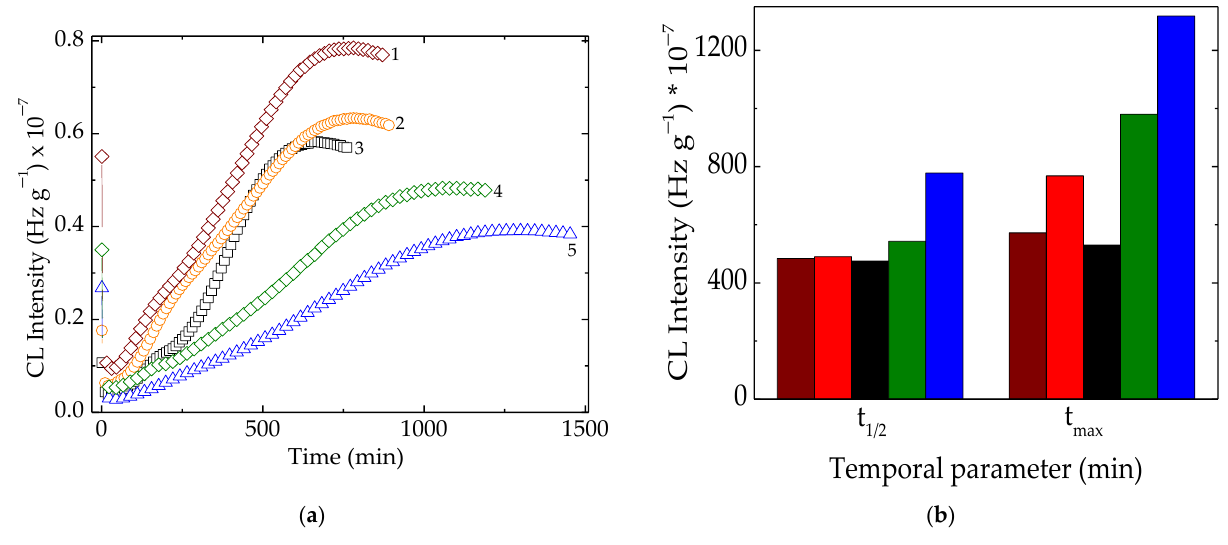
Figure 3. ( a ) Isothermal CL curves recorded on samples with different polyolefin compositions. ( b ) Temporal kinetic parameters of t 1/2 and t max characterizing the progress of oxidation in the studied samples. Testing temperature: 160 °C; irradiation dose: 50 kGy. Compositions: (1) LDPE/UHMWPE; (2) LDPE/HAp; (3) LDPE/HAp/RM; (4) LDPE/UHMWPE/HAp; (5) LDPE/UHMWPE/HAp/RM. The symbol colors are the same for both graphs. The colors of the bars have the same meanings as in ( a ).